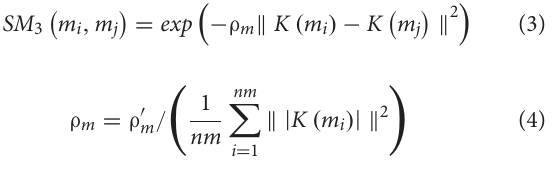
Frontiers in Genetics |